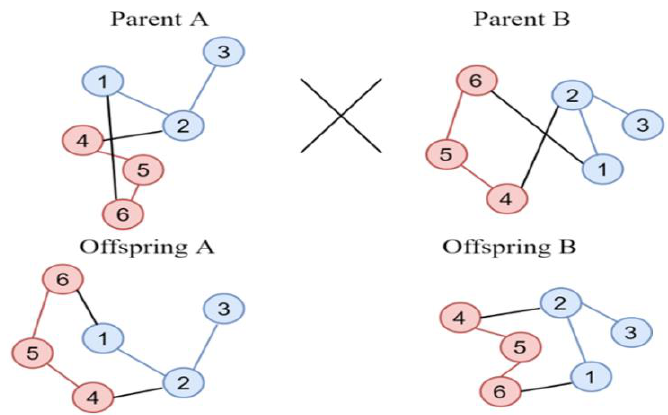
Figure 6. Single-link crossover.